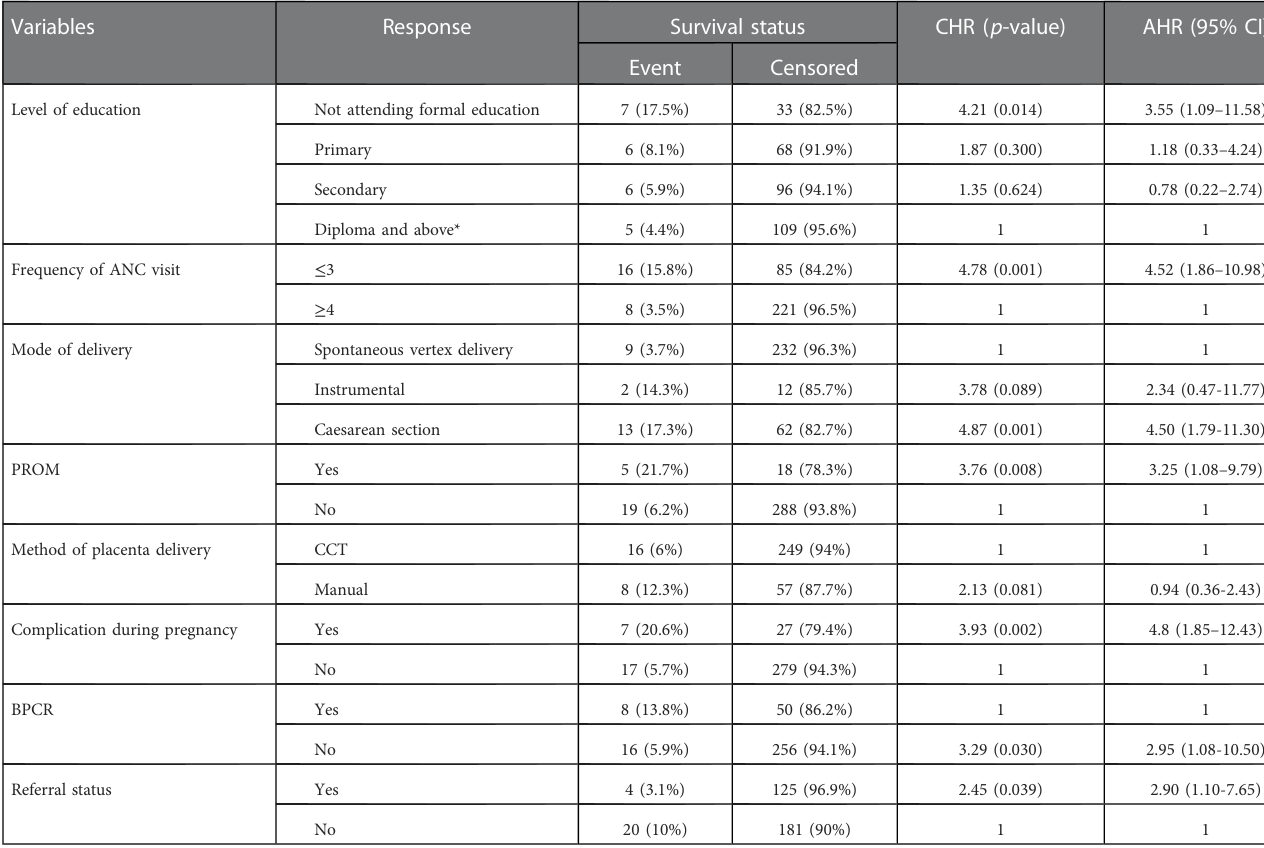
TABLE 3 Cox regression analysis predictors of puerperal sepsis among postnatal women at DMCSH, Debre Markos, northwest Ethiopia, 2020/21 ( N =330).